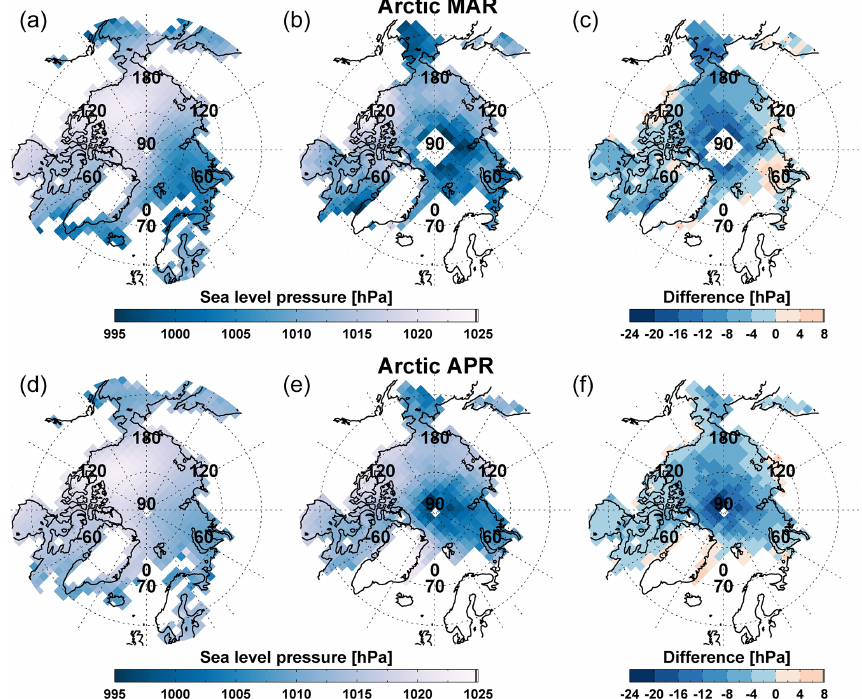
Figure 4. Monthly sea level pressure for the mean field (a, d) , the enhanced BrO case (b, e) , and sea level pressure anomalies (difference of sea level pressure between the enhanced BrO case and the mean field) (c, f) over the Arctic in March (a–c) and April (d–f) .